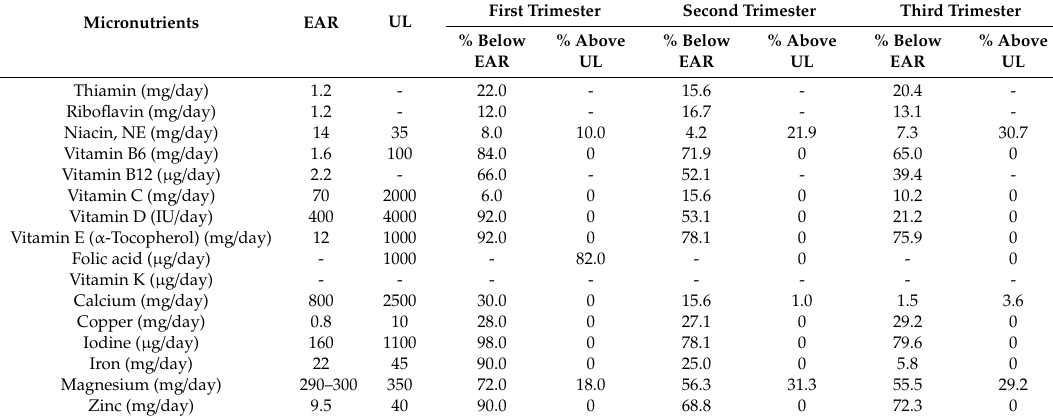
Table 7. The proportions of pregnant women that reported micronutrient intakes from food and supplements below or above the corresponding dietary reference